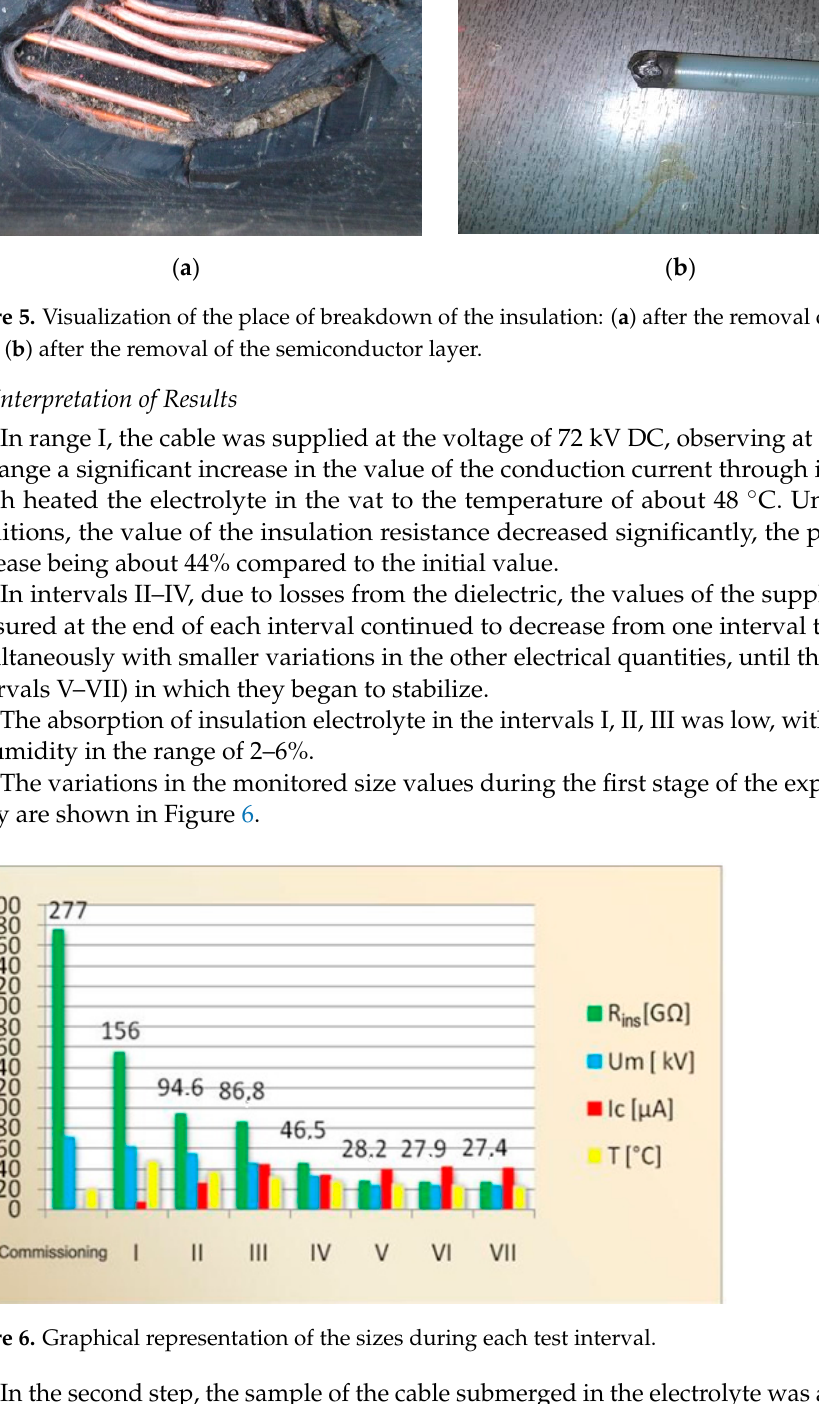
Figure 7. Graphic representation of sizes in the absence of supply voltage.